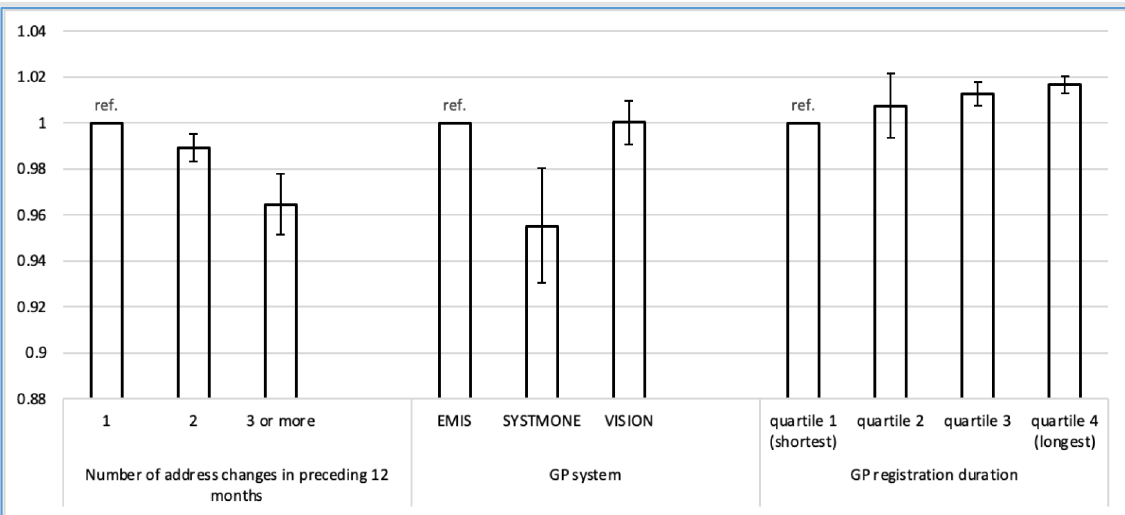
Figure 1: Adjusted prevalence ratios and 99% CIs for number of address changes in the preceding 12 months, GP EHR system, and GP registration